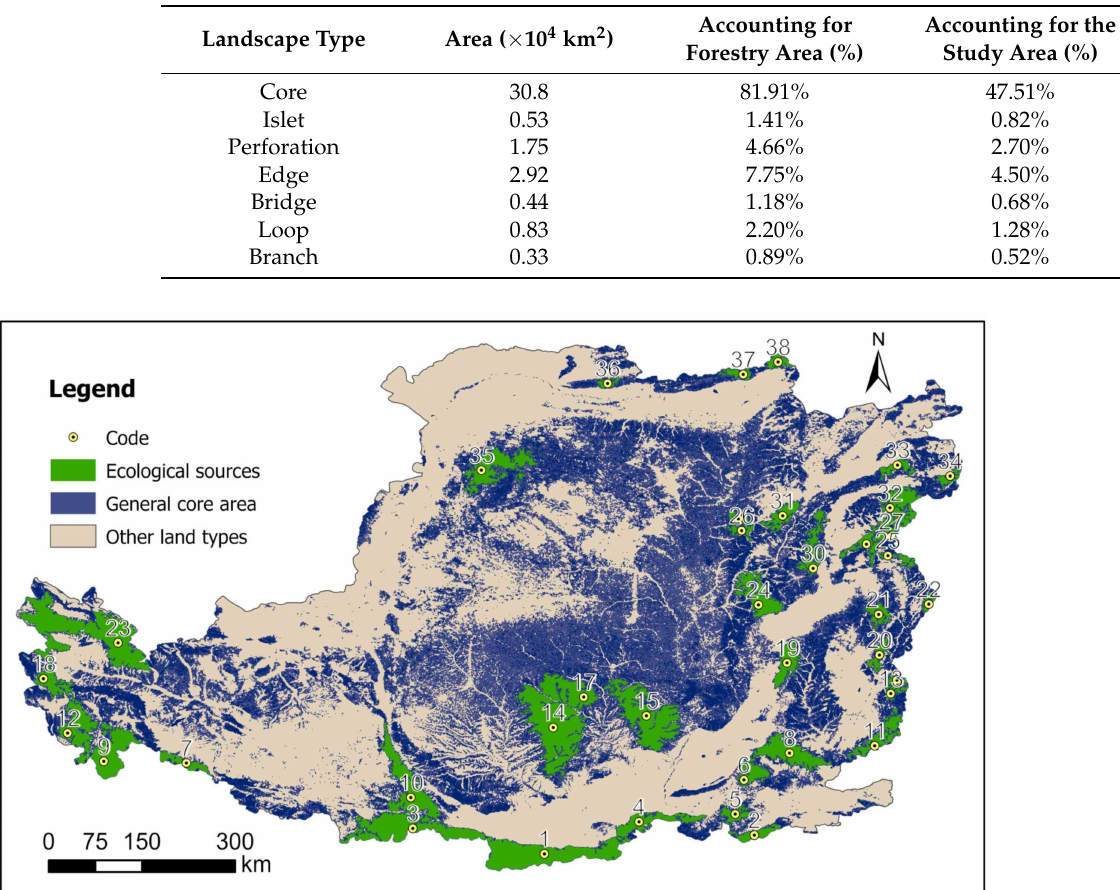
Figure 4. Results of the core patch importance